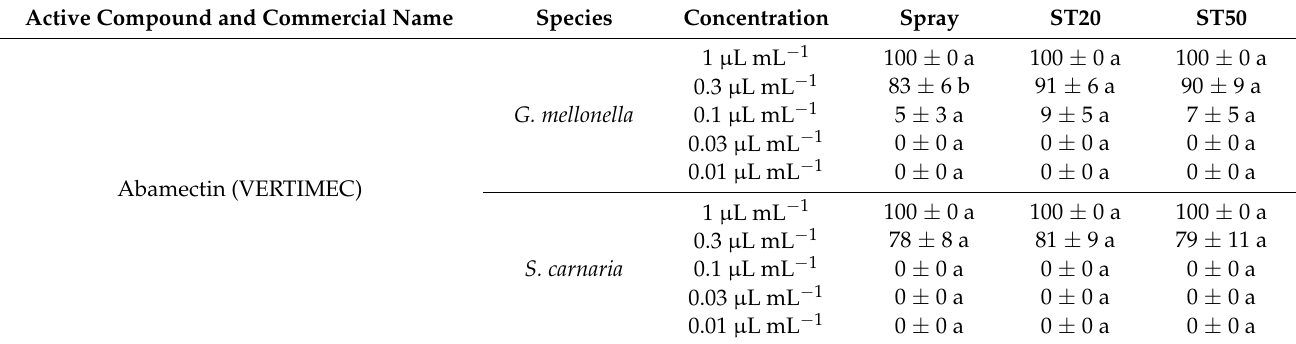
Table 1. Percentage of G. mellonella and S. carnacia larvae that died following treatment with five concentrations of abamectin by spray system, ST20, and ST50. Data are means ± standard deviation; different letters indicate statistically significant differences within concentration (Duncan’s test).